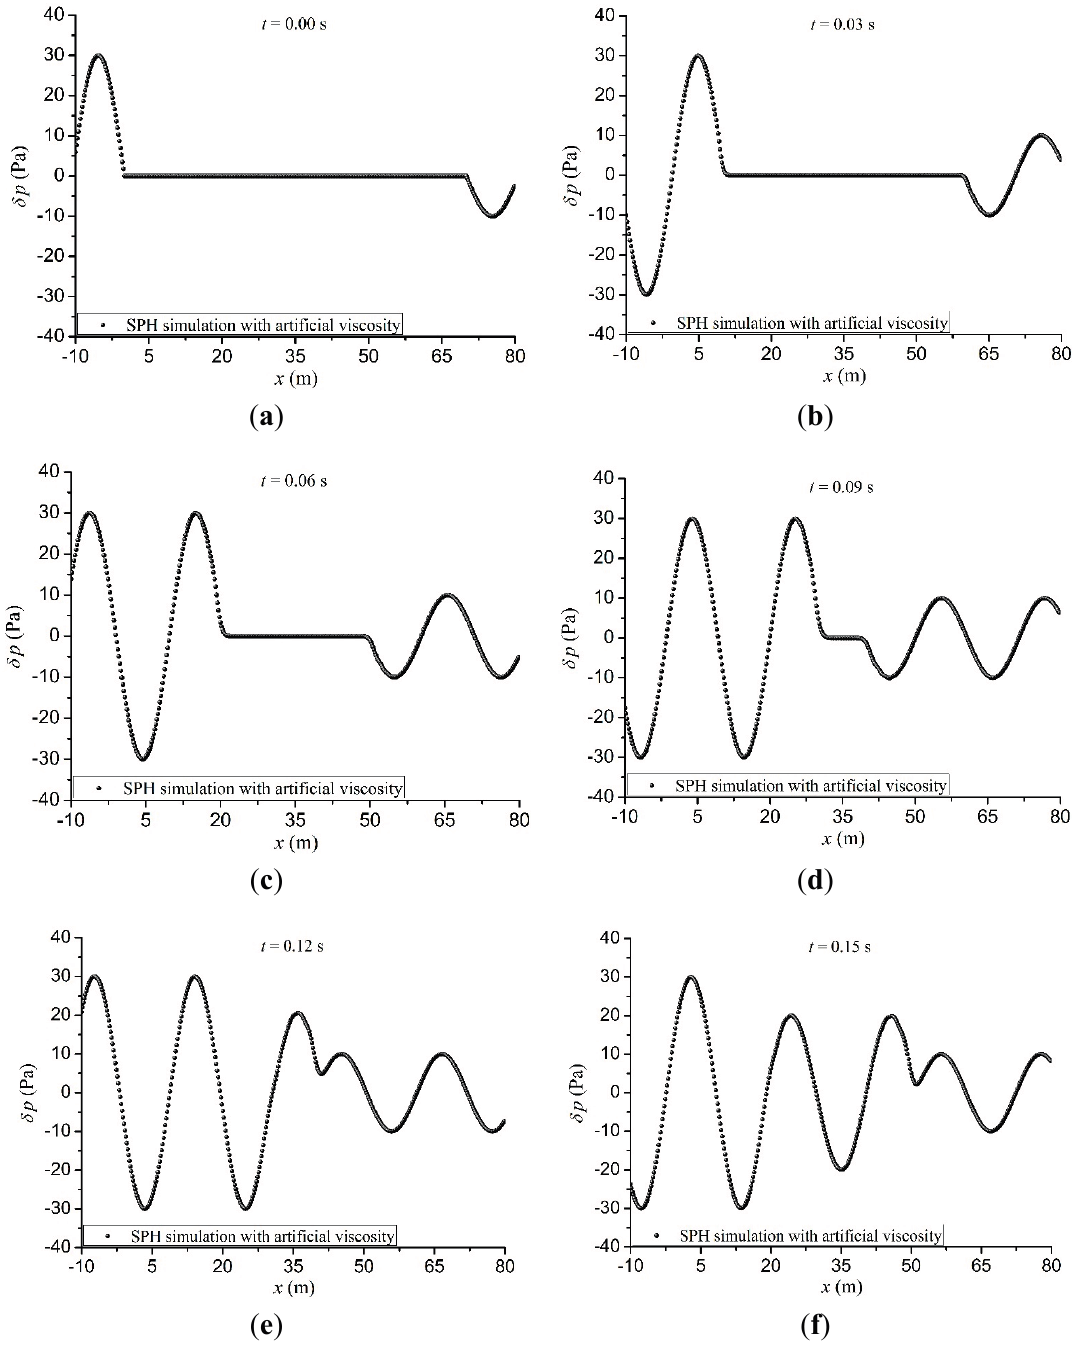
Figure 3. Simulating sound interference using the SPH algorithm with artificial viscosity. ( a to f ) Sound interference simulation results at t = 0.00, 0.03, 0.06, 0.09, 0.12 and 0.15 s,